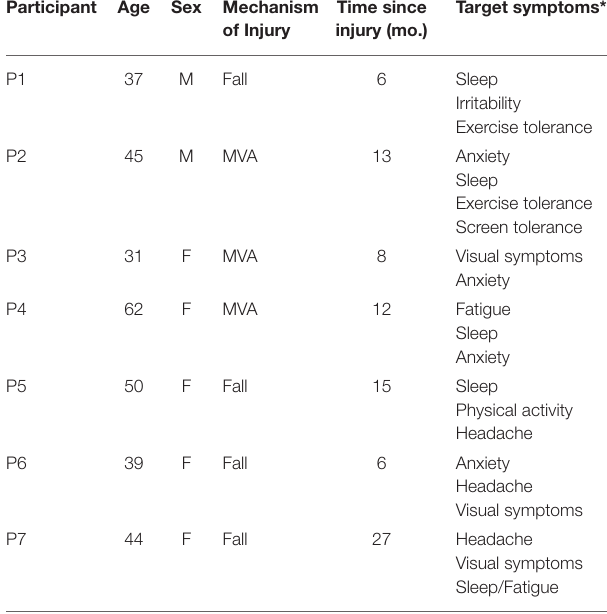
TABLE 1 | Patient demographics. Participant Age Sex Mechanism